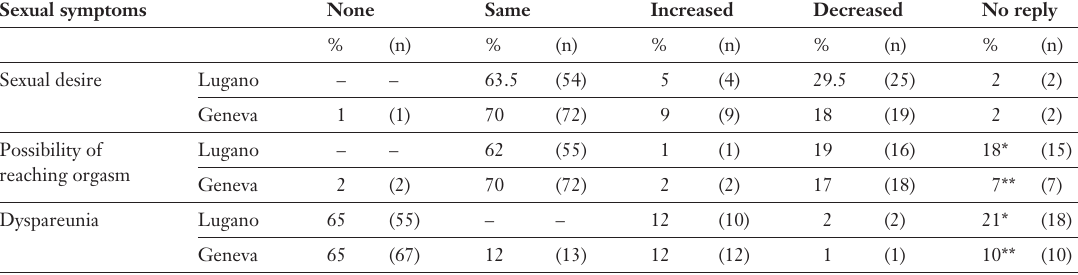
Sexuality after TOP: comparison